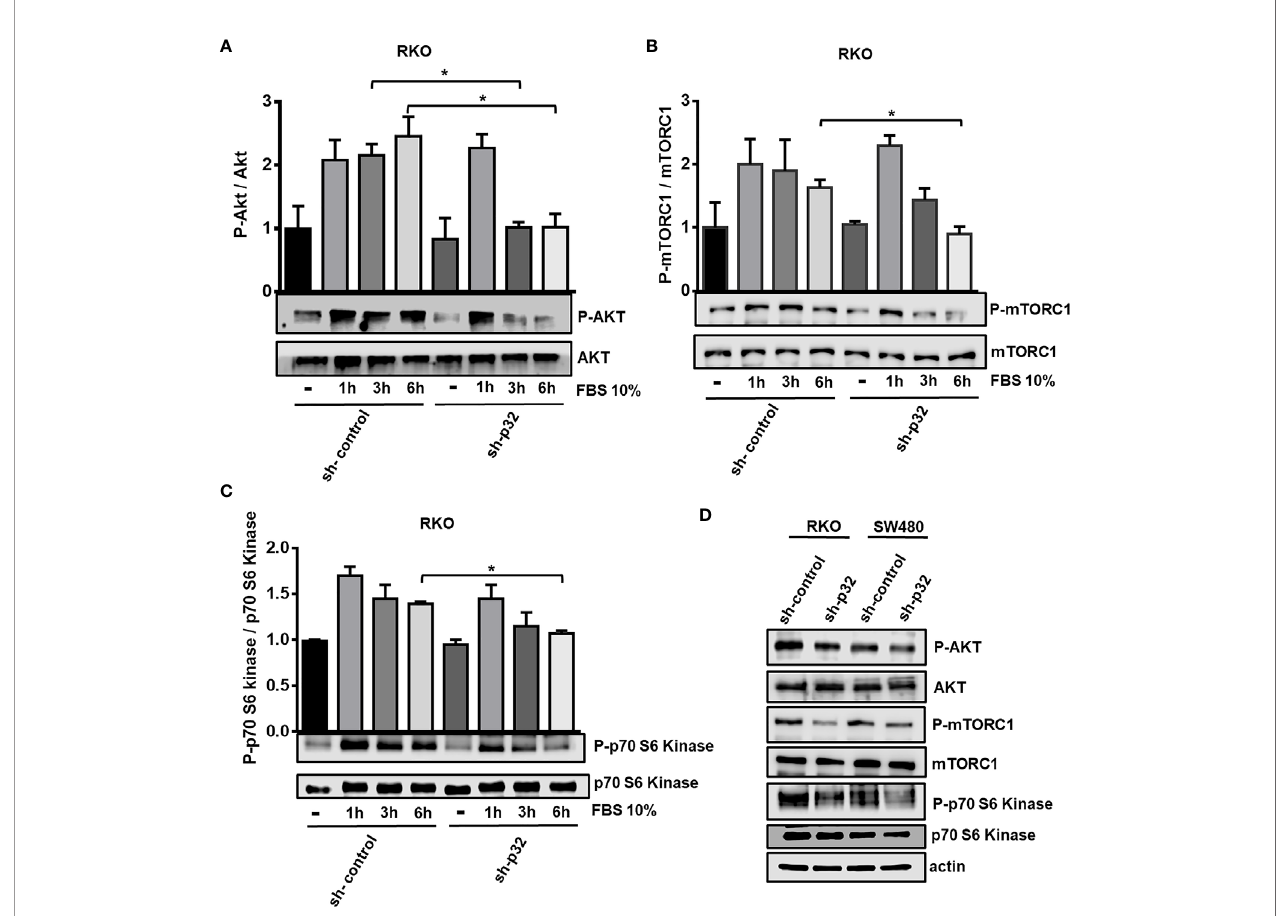
FIGURE 3 | Knockdown of p32 negatively affects the activation of the Akt-mTor signaling pathway in RKO and SW480 cells. 3x10 5 RKO sh-control or sh-p32 cells were seeded on a 6-well plate and grown for 48 hours. After that time, the cells were starved for 16 hours with serum free media. Next, cells were stimulated with 10% FBS-DMEM for 1, 3 or 6 hours to evaluate the activation of Akt (A) mTOR (B) and p70-S6 Kinase (C) proteins by Western blot. Densitometric analysis was performed to quantify the levels of both phosphorylated and total proteins. The levels of each phosphorylated protein were normalized with respect to its corresponding total protein. The data is presented as the mean values ± SEM from three independent experiments, *p < 0.05. (D) For evaluation of the rate of activation of the AKT-mTOR-p70S6 Kinase signaling pathway at longer times, 1x10 6 RKO or SW480 (sh-control or sh-p32) were seeded in p60 plates and grown in 10% FBS-media for 48 hours. After that time, the cells were lysed and the levels of activation of AKT, mTOR and p70-S6 Kinase protein were evaluated by Western blot. Representative blots from 3 independent experiments are